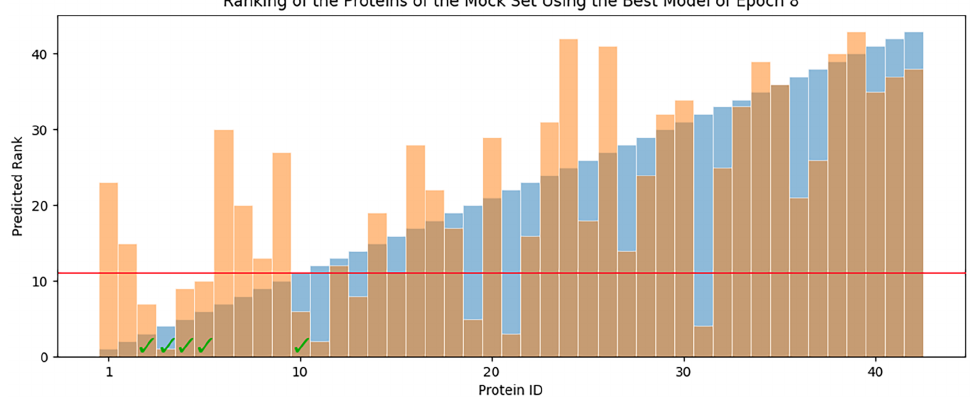
Figure 7 Predicted ranks (orange) of the protein sequences in a mock set versus their actual rank (blue). The proteins under the red line were among the top 10. The check-marked bars indicate top 10 protein sequences which were also predicted by the best model as top